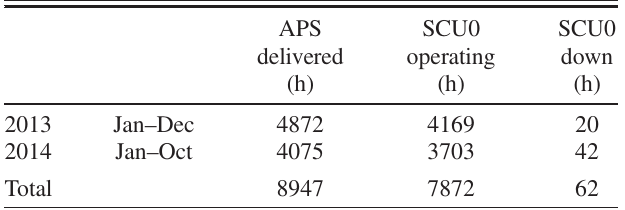
TABLE VIII. SCU0 Operational